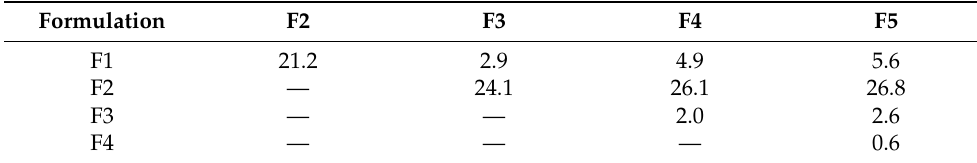
Table 5. The calculated values of differences between group means. Formulation